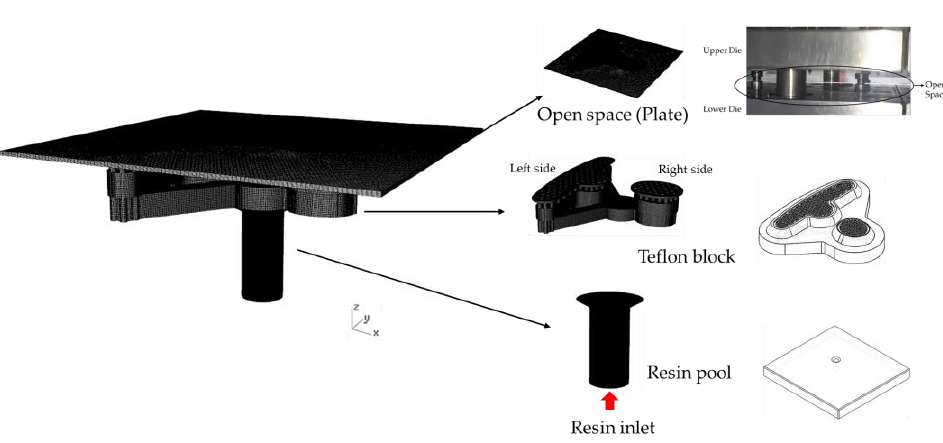
192 Figure 8. Mesh model used in the dipping process.